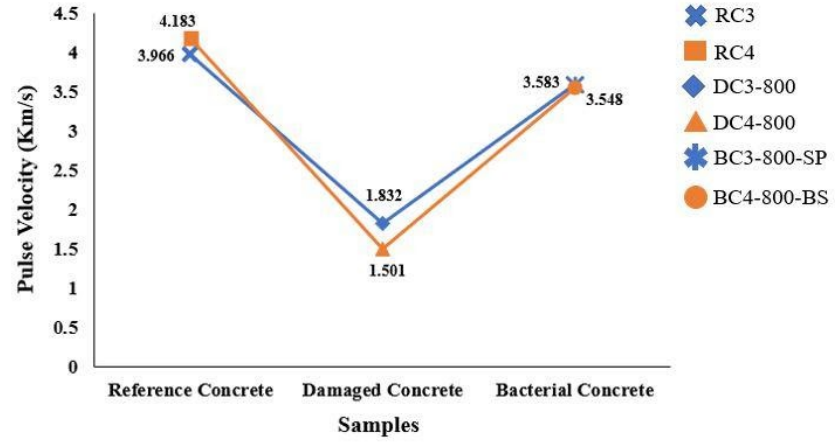
Figure 7. Comparing the ultrasonic pulse velocity results of the control specimens, damaged at 800 °C and repaired by type I and II bacteria.